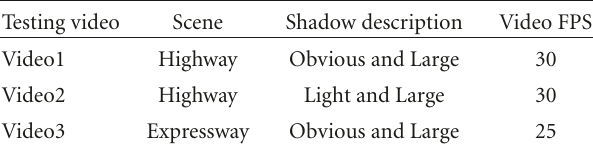
Table 1: Descriptions of testing videos for vehicle